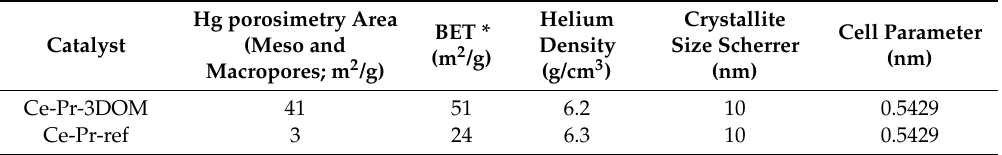
Table 1. Quantitative results of the fresh catalysts’ characterization by X ‐ ray diffraction, helium picnometry, N 2 adsorption, and mercury intrusion porosimetry.